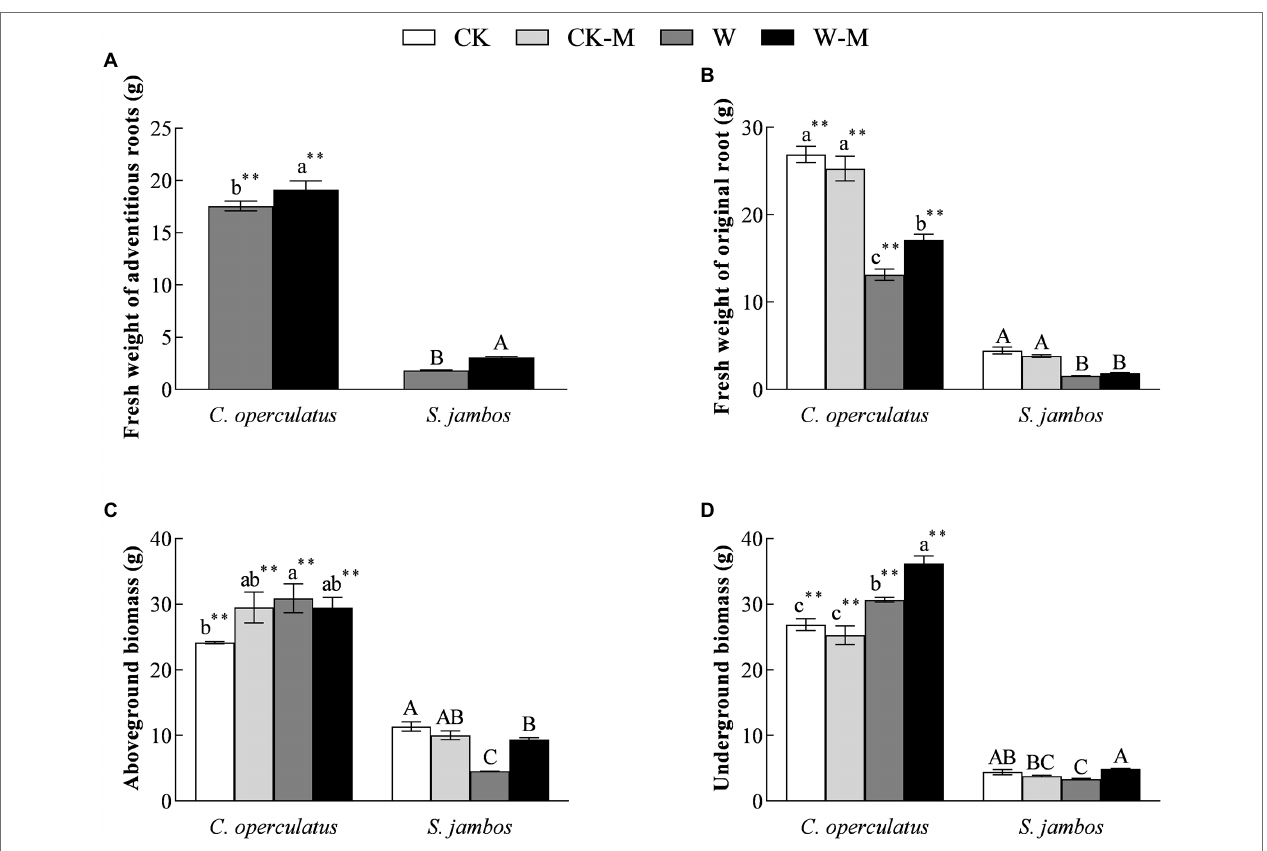
FIGURE 1 | The variations of fresh weight of adventitious roots (A) , fresh weight of original root (B) , aboveground biomass (C) and underground biomass (D) in Cylindrocopturus operculatus and Syzygium jambos among different treatments. Values are means ± SE ( n = 6). Different little and capital letters indicate significant differences among different treatments within the same species according to ANOVA’s test ( p < 0.05). CK, pure planting pattern under well-watered condition; CK-M, mixed planting pattern under well-watered condition; W, pure planting pattern under waterlogging condition, W-M; mixed planting pattern under waterlogging